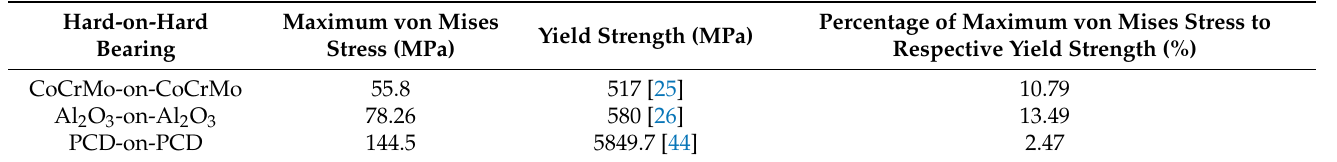
Table 3. Percentage of maximum von Mises stress to respective yield strength from hard-on-hard